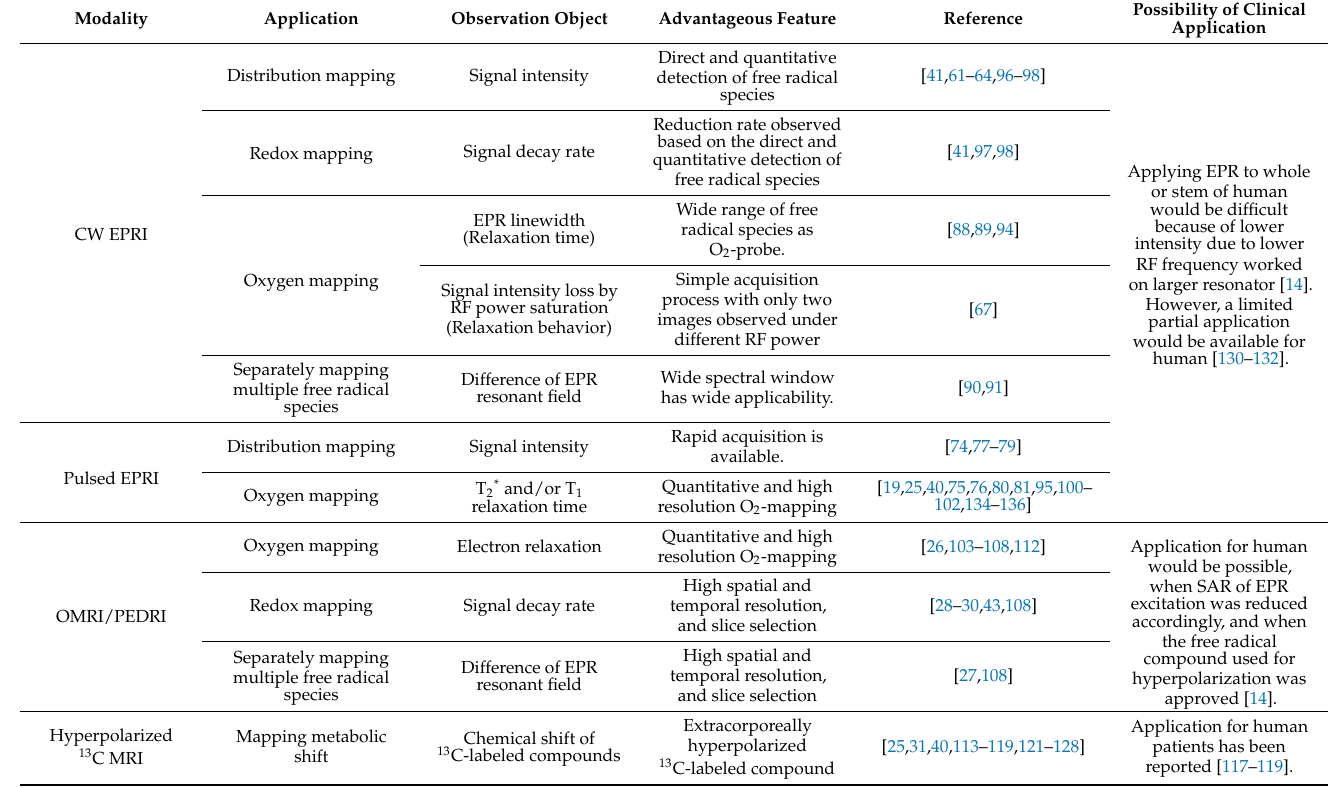
Table 1. Technical and practical features of EPRI and related imaging